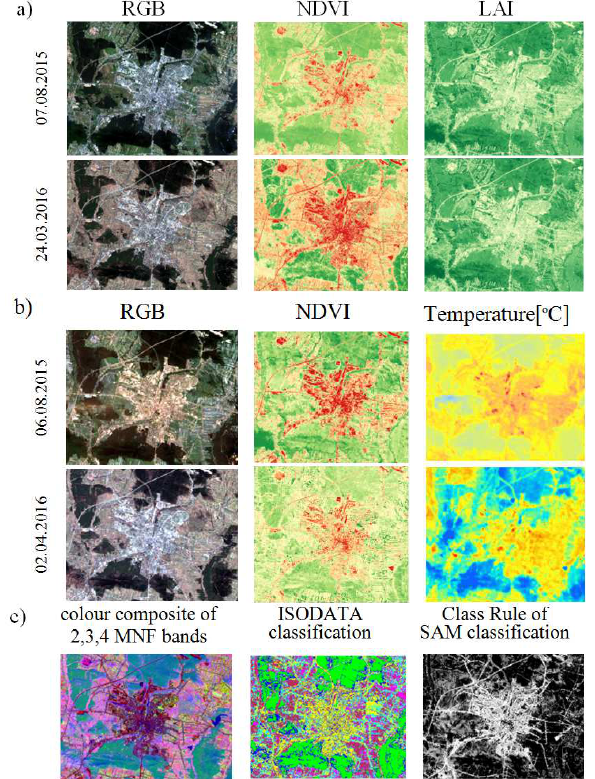
Figure 5. Images of a) Sentinel-2 b) Landsat-8 and c) their